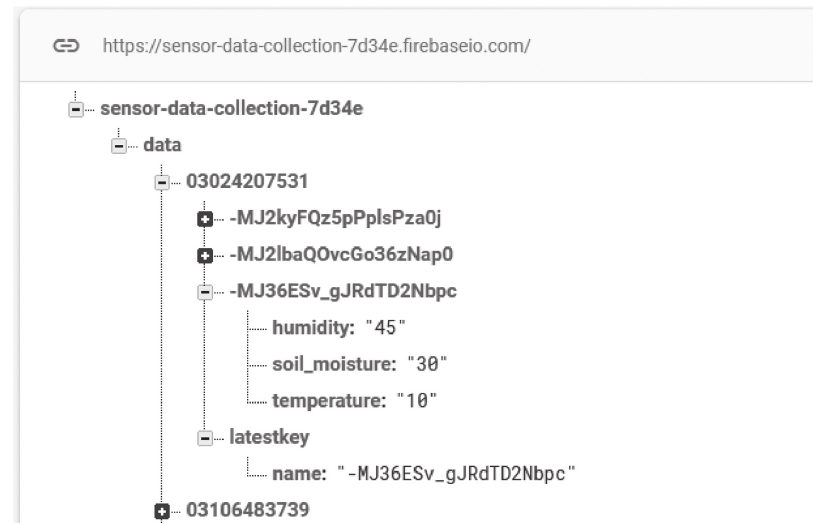
Figure 11: Edge server handling data from sensors via the HTTP